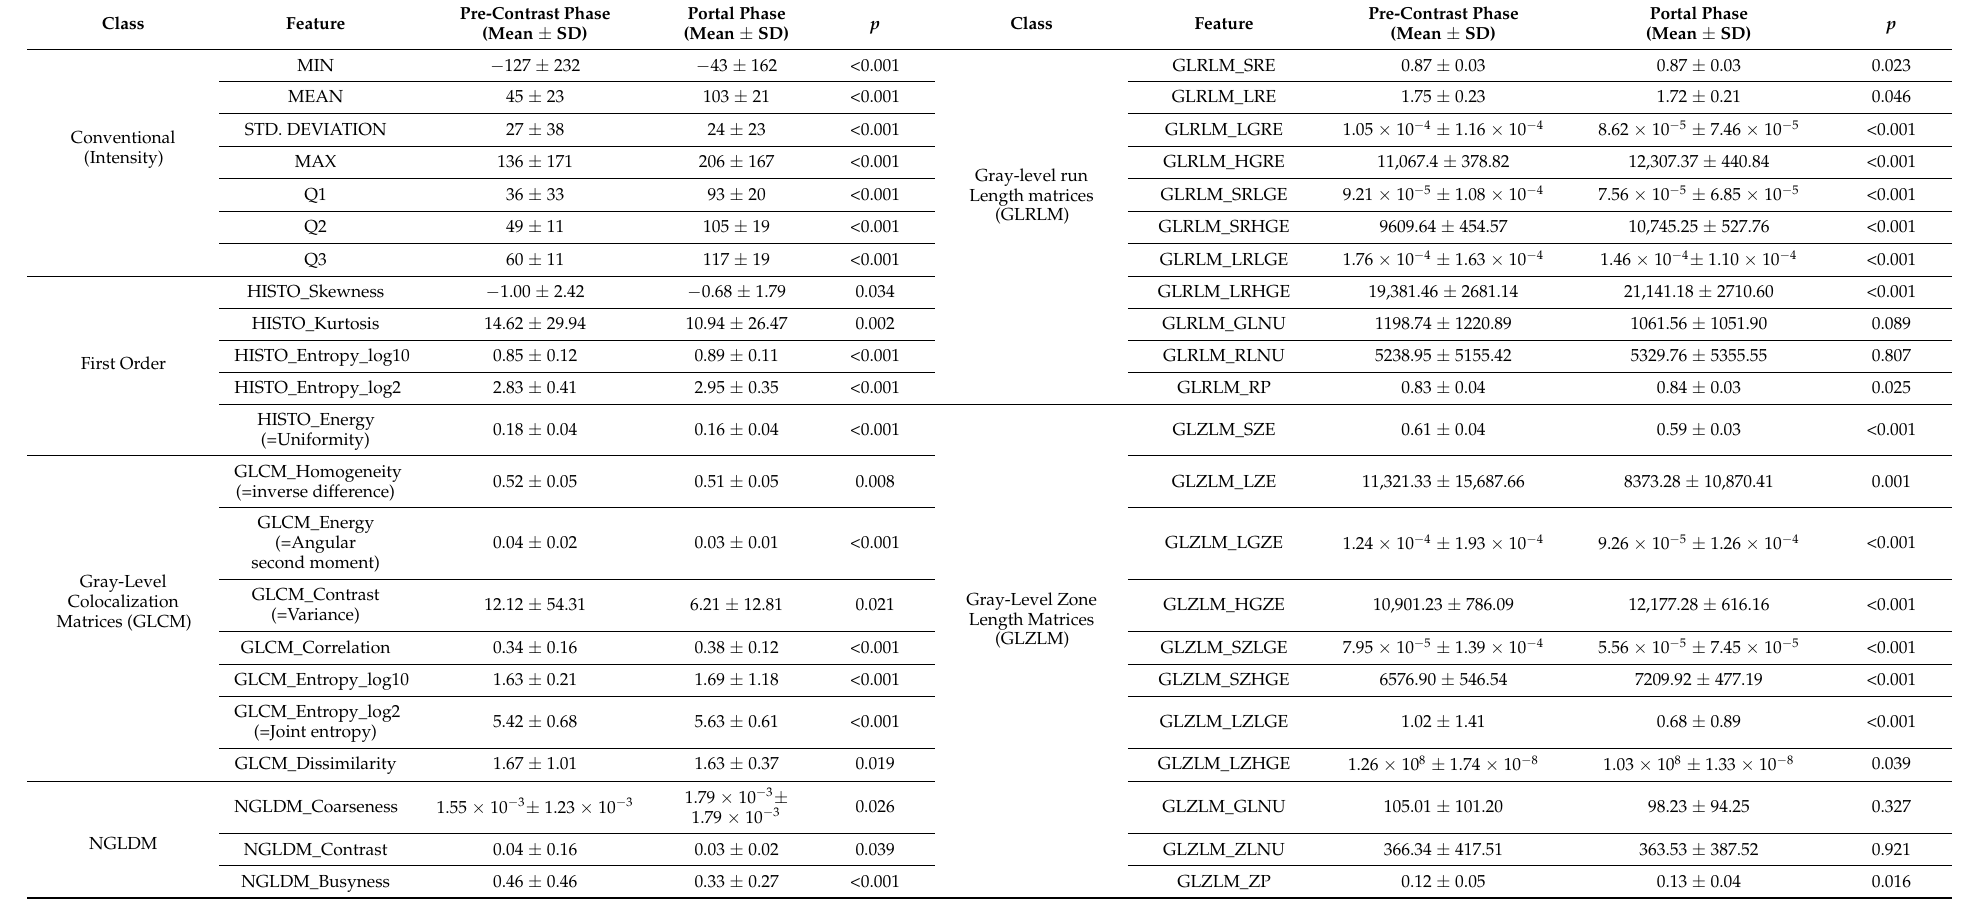
Table 3. Values of the radiomics features of Margin volume of interest (VOI) in the portal and pre-contrast